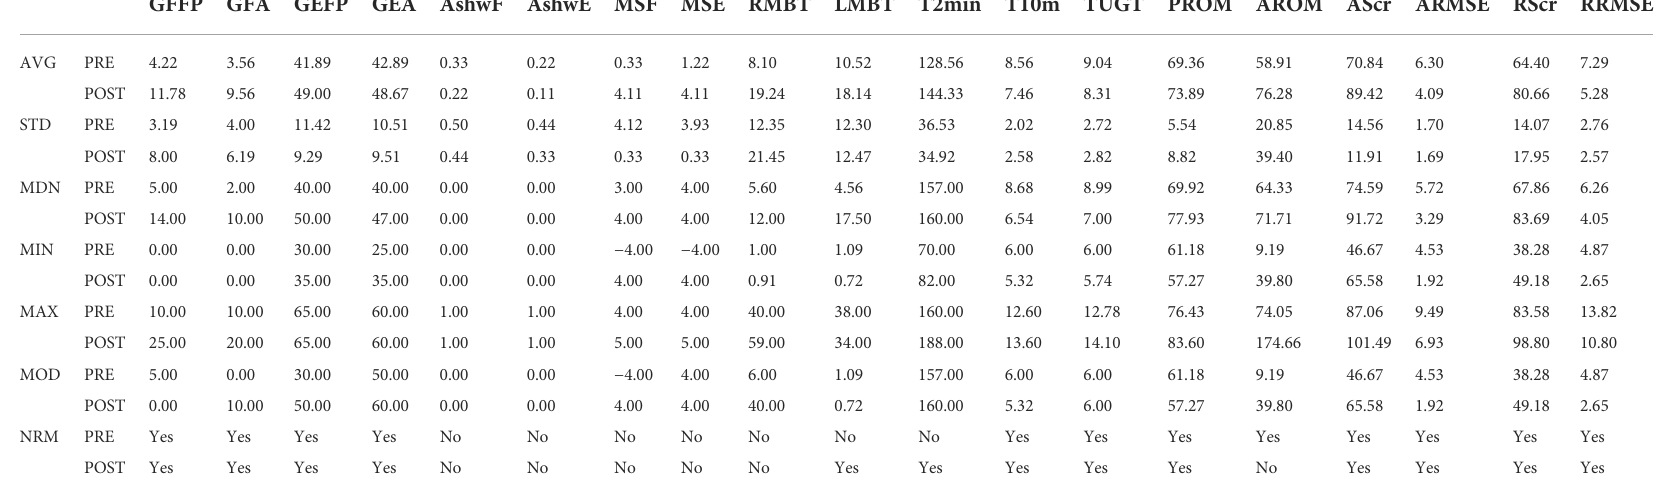
GFFP,goniometry fl exionFP;GFA,goniometry fl exionA;GEFP,goniometryextensionFP;GEA,goniometryextensionA;AshwF,ashworth fl exion;AshwE,ashworthextension;MSF,musclestrength- fl exion;MSE,musclestrengthextension;RMBT,right monopodal balance test; LMBT, left monopodal balance test; T2min, 2 min walking test; T10m, 10 m walking test; TUGT, timed up and go test; PROM, passive ROM; AROM, active ROM; ASCr, active score; ARMSE, active RMSE; RScr, resistive score; RRMSE, resistive